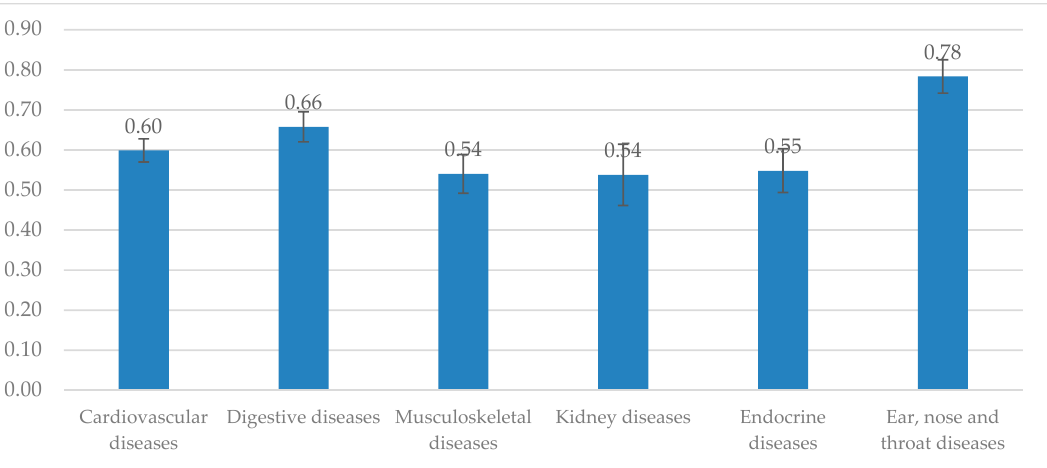
Figure 2. EQ-5D-5L index by chronic conditions.